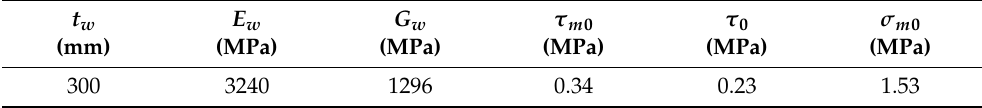
Table 1. Mechanical properties of masonry